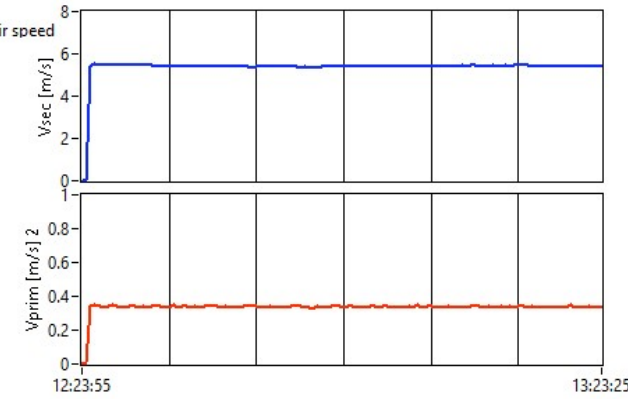
Figure 17. Evolution of primary and secondary air speed with a ratio of 1/3 and a flow rate of 25/75 L/min, during the test.